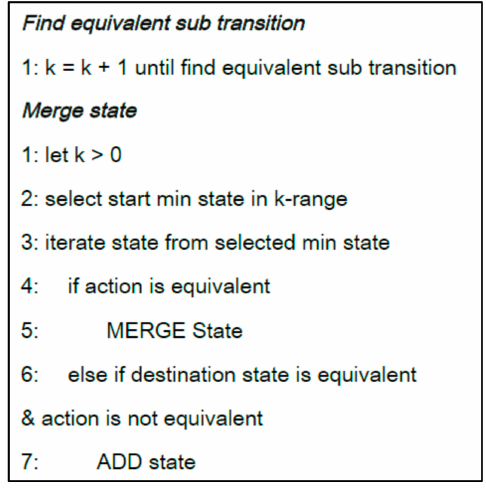
Figure 6. Pseudo-code for Gk-tail